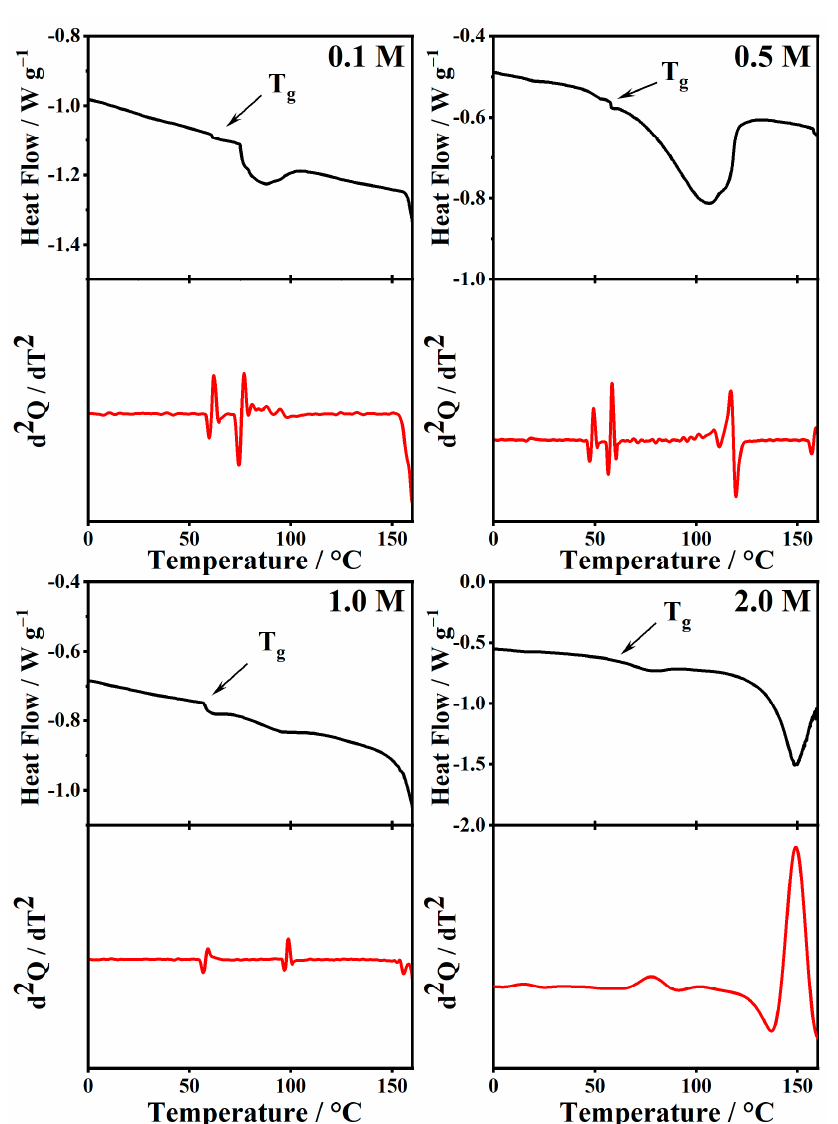
Figure 18. The Differential Scanning Calorimetry (DSC) curve (black solid curve) and the second derivative of the respective DSC signal (red dot curve) were collected during a heating process with a rate of 10 °C/min on PMMA-Li-PC gel polymer electrolyte at different salt concentrations: 0.1 M, 0.5 M, 1 M and 2 M.